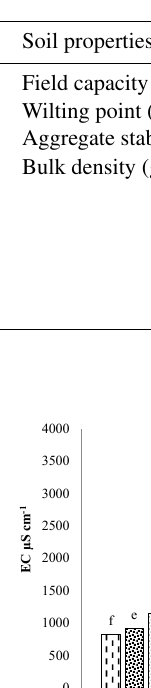
Table 1. Properties of the soil used in the experiment (mean ± SD).